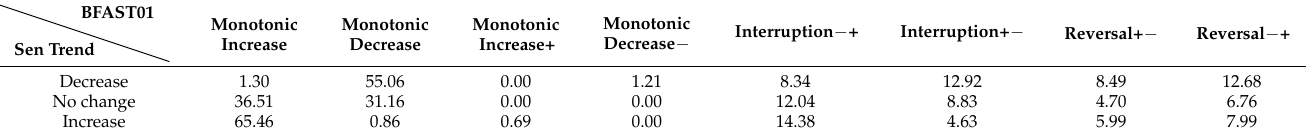
Figure 9. Distribution of NDVI and LULC in the study area. Table 7. Conversion table of BFAST01 and Sen slope estimation results (%).